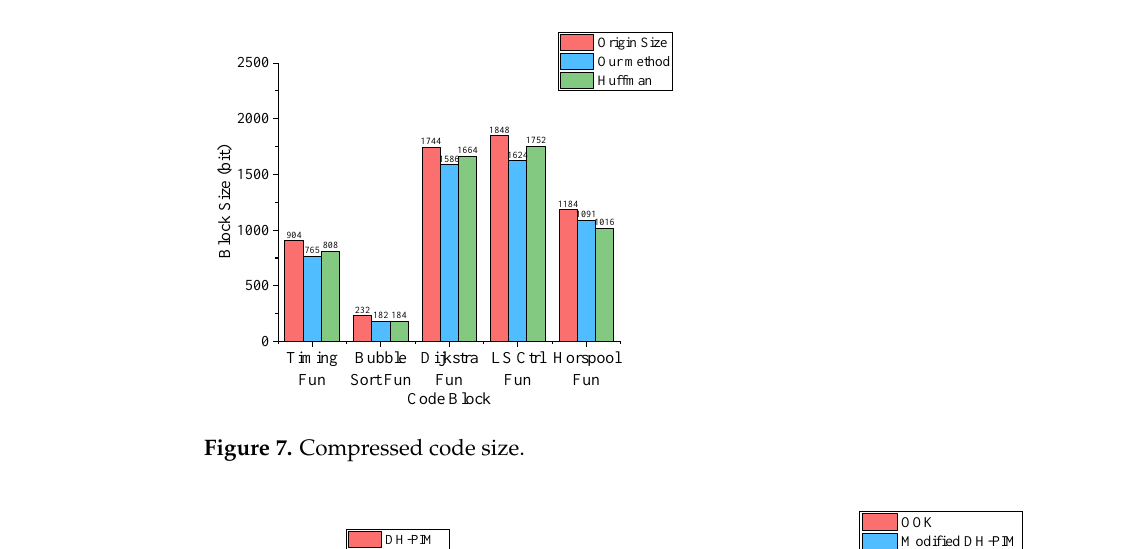
( b ) Figure 9. ( a ) Completion time in indoor environment (650 lux); ( b ) completion time in indoor environment (2100 lux).